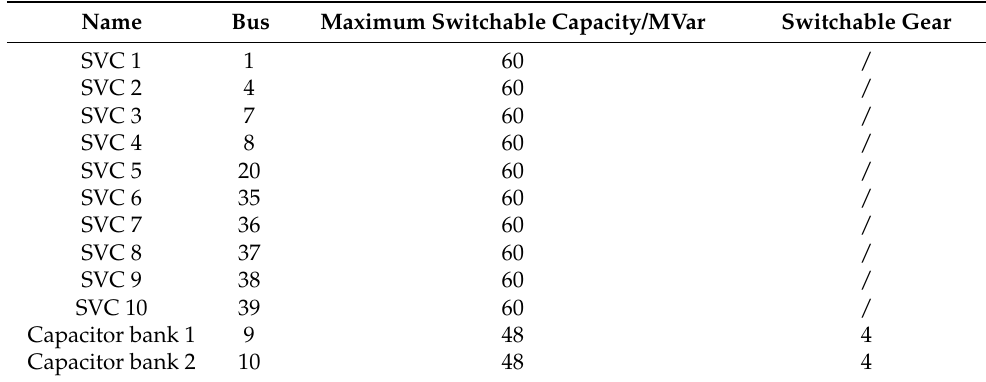
Table 2. Parameters of switchable reactive power compensation device.